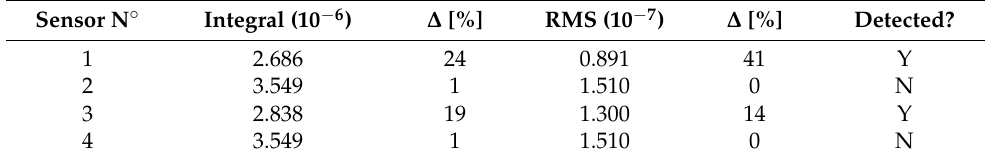
Figure 9. Scheme of void and IE device layout, void below sensor 1. Detected Y—Yes, N—No, W—Warning.